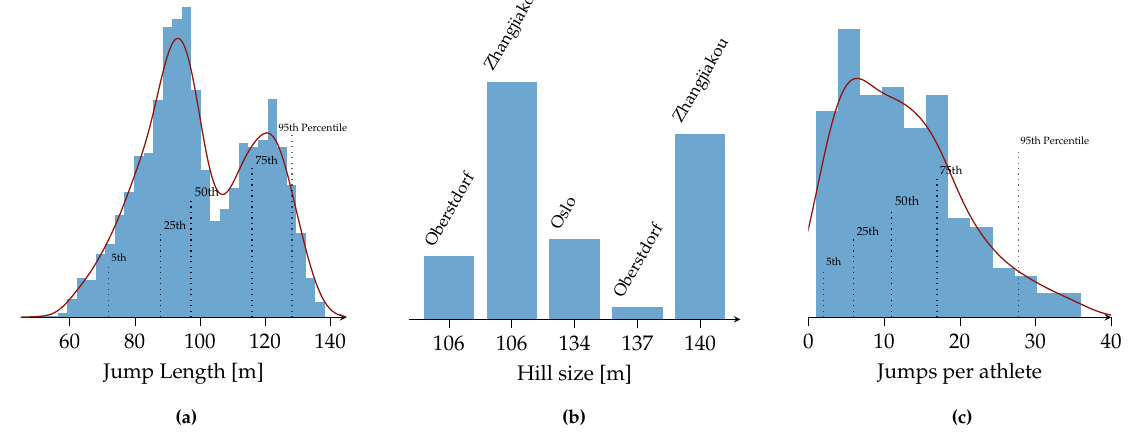
Figure 2. Distribution of the ( a ) jump length, ( b ) jumps per venue, and ( c ) the number of jumps per athlete present in the dataset of this study. The kernel density estimate using Gaussian kernels is also shown in red for the jump length and the jumps per athlete. Table 1. Summary of the dataset used in this study. Data were acquired during competition and training of world-leading athletes. The venue data is named according to the ski jumping hill construction standards of the FIS [34].